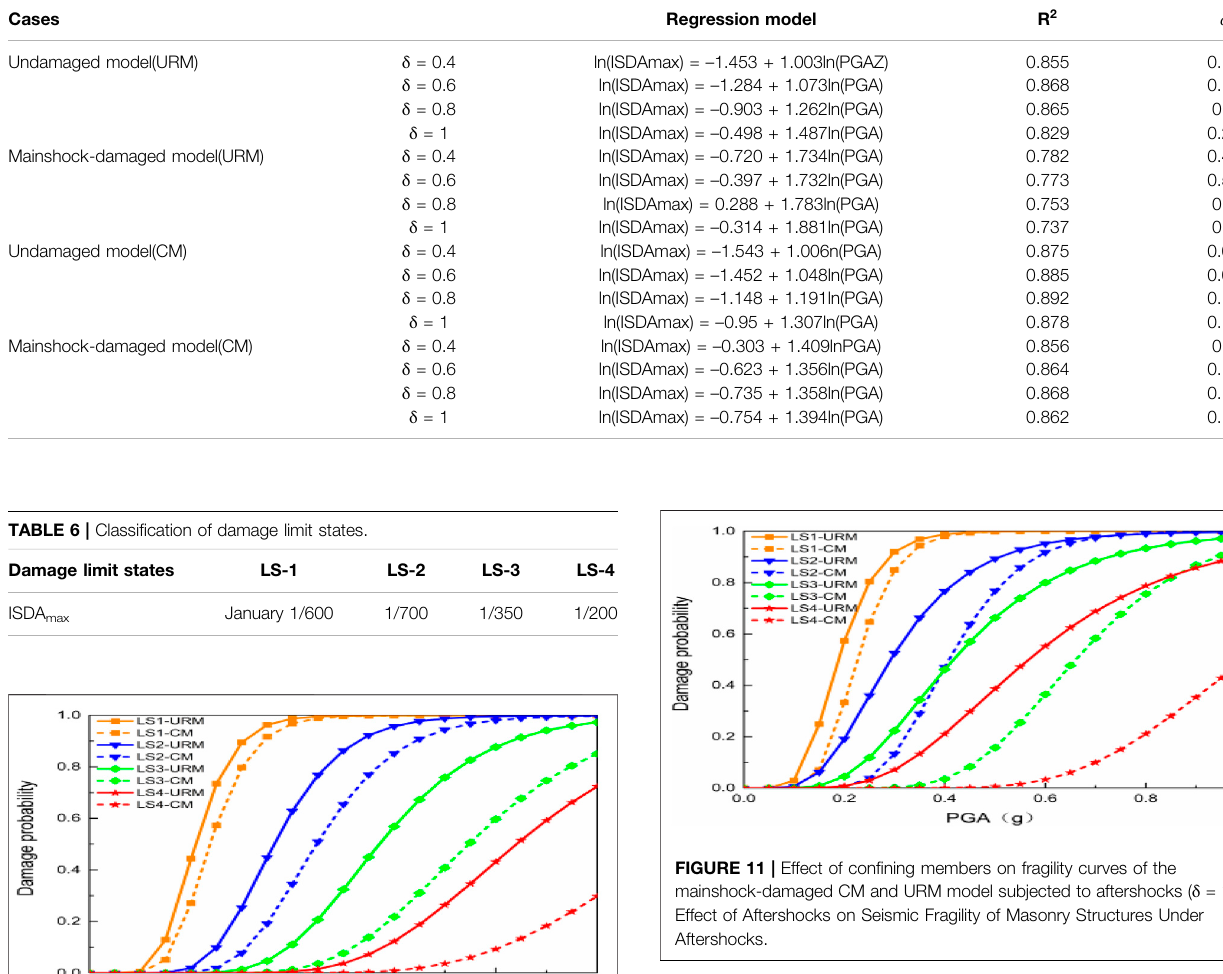
TABLE 5 | Parameters for the probabilistic demand models of URM and CM subjected to aftershock.